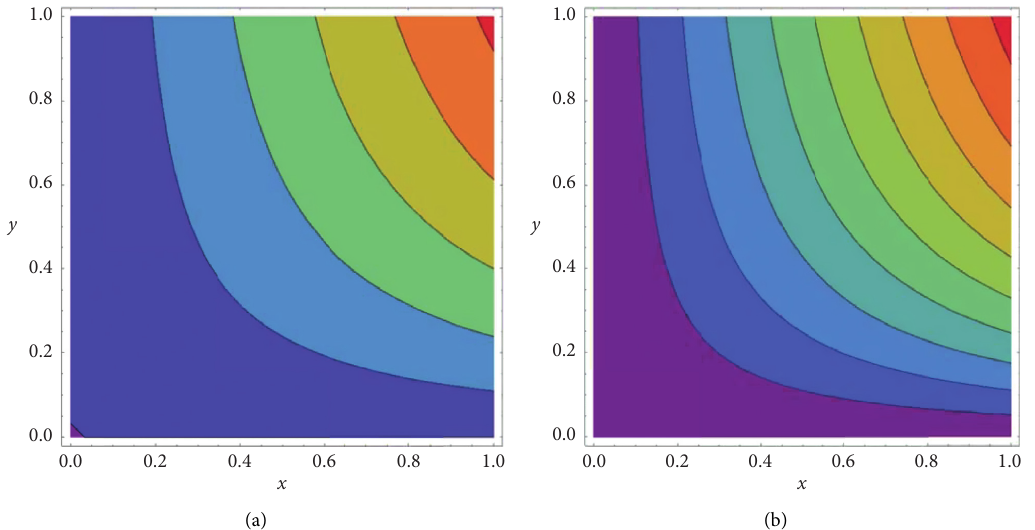
Figure 9: Stream lines for S � 0.0. (b) Stream lines for S �